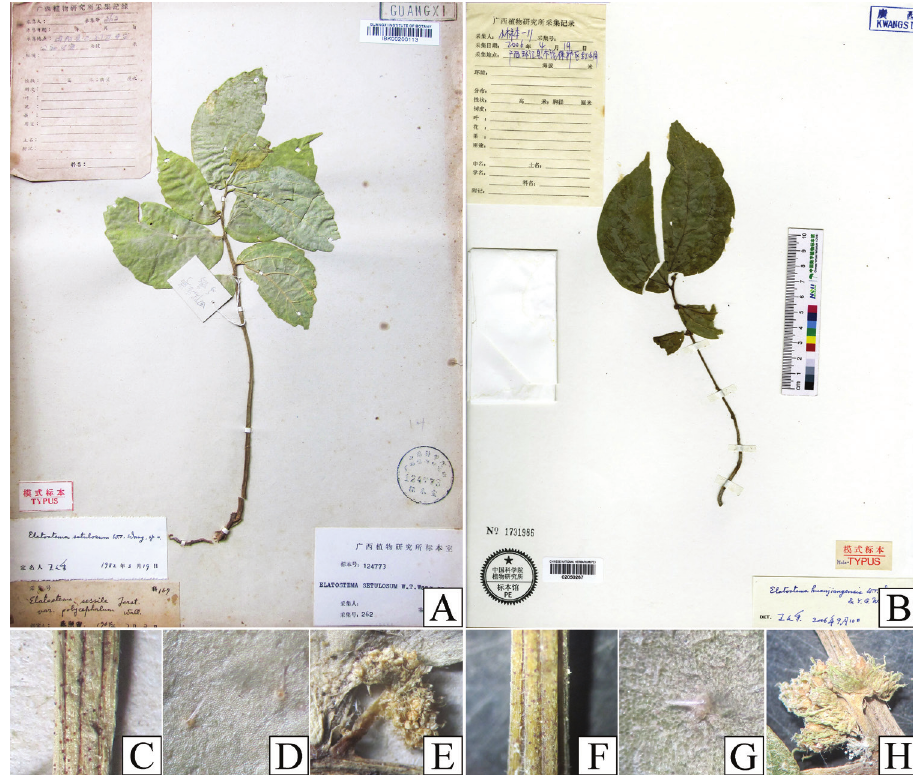
Figure 2. Comparison of type specimens between Elatostema setulosum ( A, C–E ) and E. huanjiangense ( B, F–H ): A, B habit C, F stem D, G leaf pubescence E, H pistillate